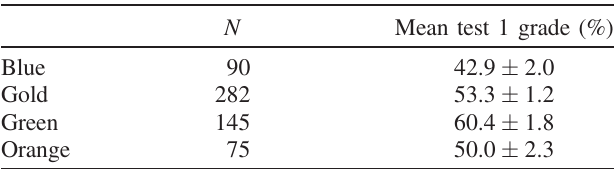
TABLE VIII. Mean test 2 grade for students with a dominant personality type.